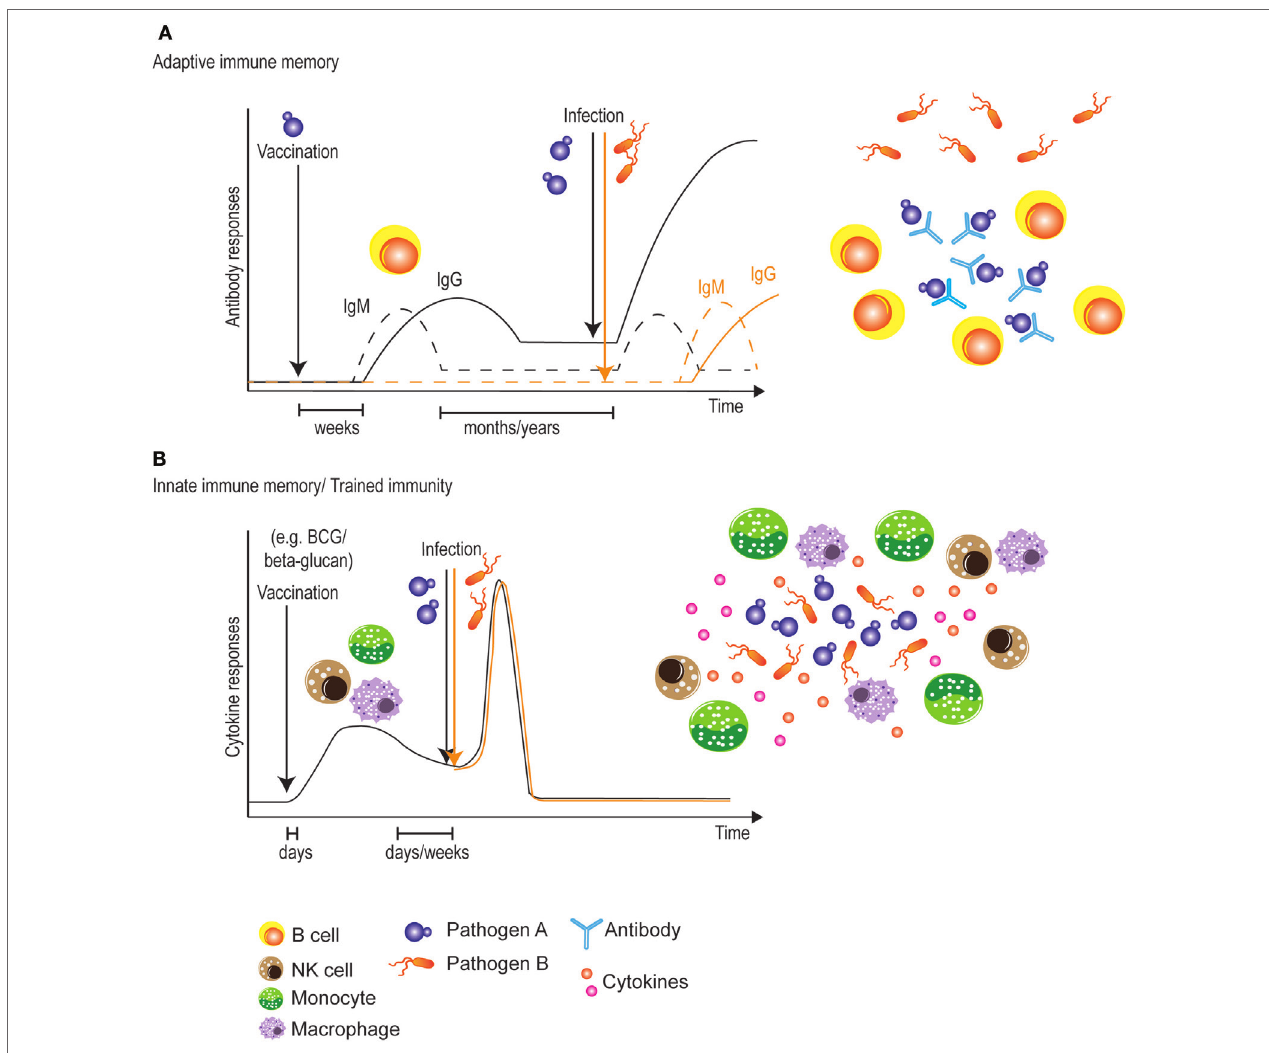
FiGURe 2 | Vaccination strategies targeting adaptive or innate immune memory. (A) Classical vaccines initially induce a slow adaptive immune response. During this primary response, however, adaptive immune memory is raised, allowing for a more rapid and stronger secondary response upon encounter of the targeted pathogen. This protection is very long-lived, but is limited to the antigens present in the vaccine. (b) Most vaccines also induce a very rapid innate immune response. During this primary response, some vaccines also “train” innate immune cells, allowing for a stronger secondary innate response against pathogens. One advantage of this innate immune memory is the non-specificity of the secondary response, which could potentially lead to broadly cross- protective vaccines. A potential disadvantage would be the relatively shorter time window of